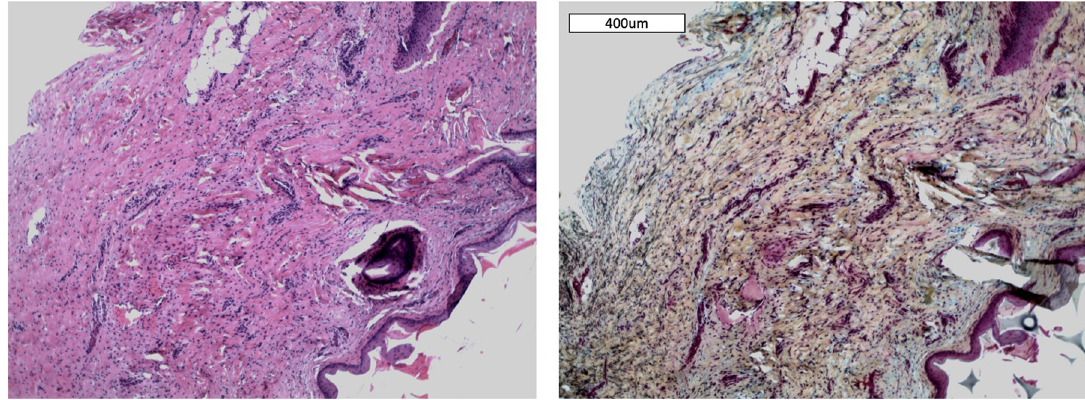
Fig 2. Excised normal VF collected during implant surgery, 10X. Movat pentachrome stain shows elastic fibers (black), collagen (yellow) and glycosaminoglycans (blue). Epithelium appears at bottom right corner.